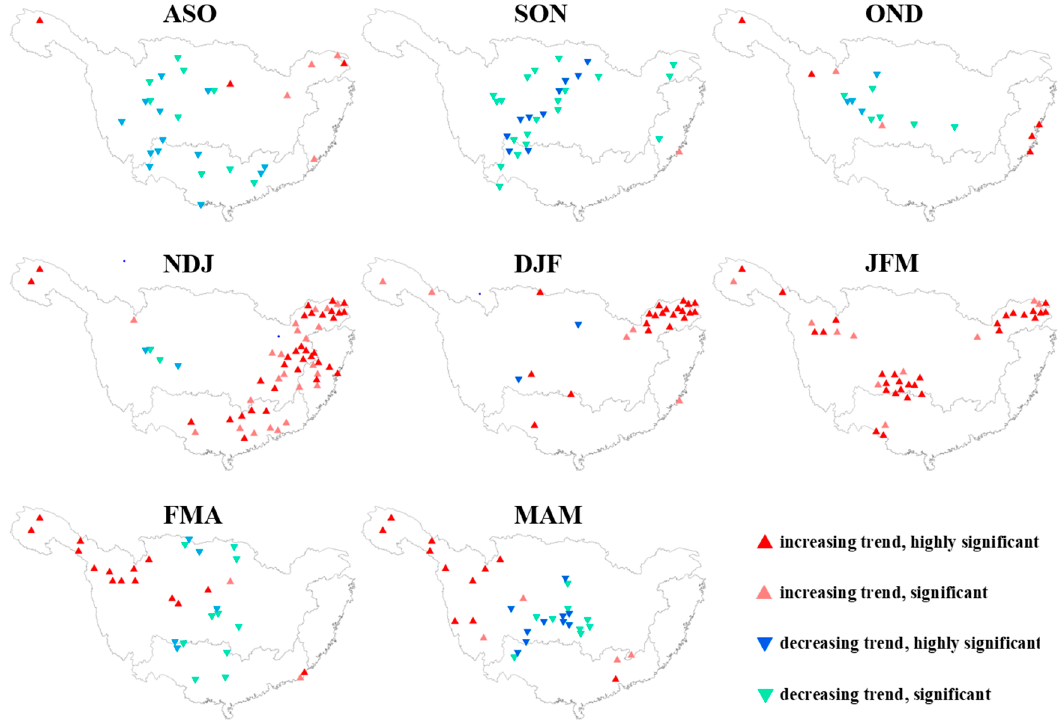
Figure 2. Results of trend analysis in moving three-month total precipitation in southern China for the period 1961–2017: Increasing and decreasing trends are indicated with red and blue symbols, with deep and light colors respectively representing 95% (highly significant) and 90% (significant) confidence levels. For definitions of abbreviations, refer to Section 2.2.